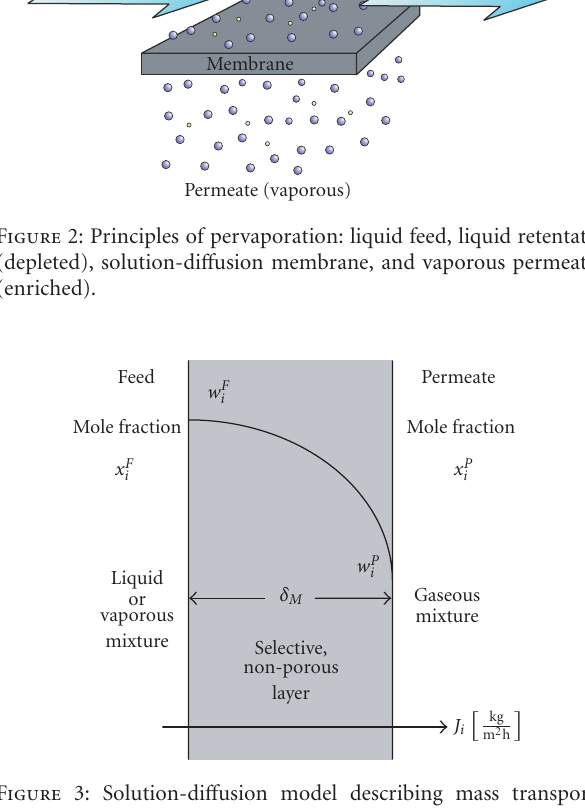
Figure 3: Solution-di ff usion model describing mass transport through polymeric